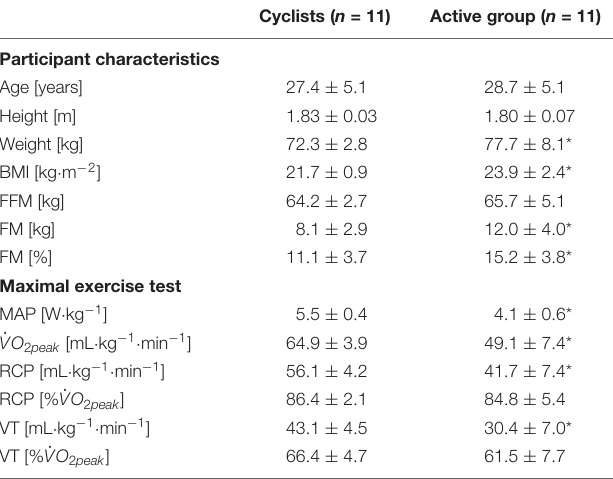
TABLE 1 | Participant physical characteristics and aerobic fitness